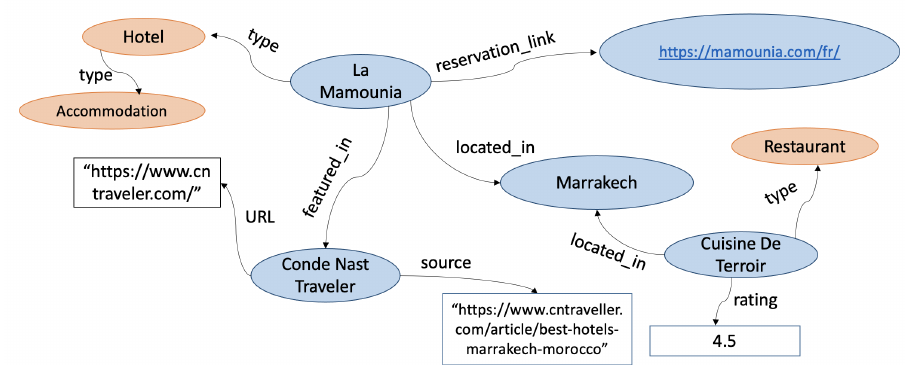
Figure 1. A knowledge graph (KG) fragment. Concepts (that typically belong in the T-Box) are shaded in orange. Links in the figure were accessed on 17 March